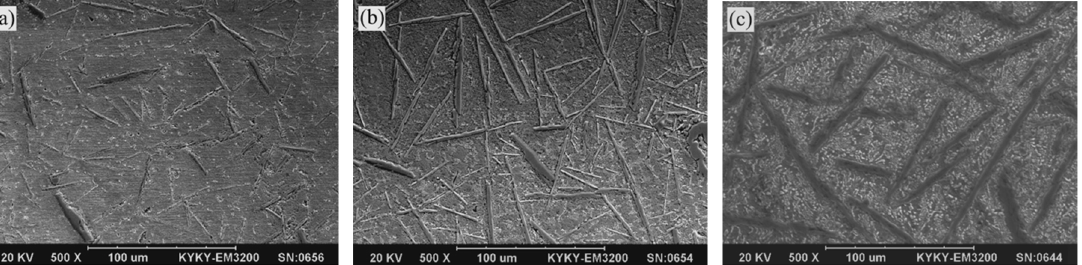
Figure 7. Microstructure on the top of the laser cladding coating (30 wt%) under different laser energy densities ( a ) 53.33 kJ/cm 2 ; ( b ) 60.00 kJ/cm 2 ; ( c ) 66.67 kJ/cm 2 .